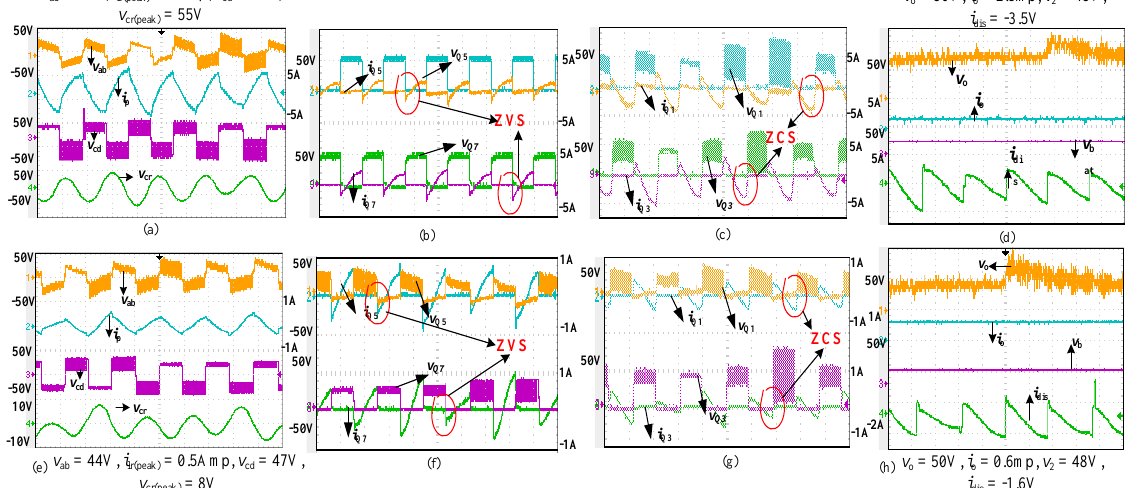
Figure 13. Reverse Mode Case 1: At full load ( a ) Waveforms of v ab , i p , v cd and v cr ( b ) waveforms showing ZVS for switches Q 5 & Q 7 ( c ) waveforms showing ZCS for switches Q 1 & Q 3 ( d ) Waveforms of v o , v b , i o and i s ; Case 2: ( e ) Waveforms of v ab , v cd , i p and v cr ( f ) waveforms showing ZVS for switches Q 5 & Q 7 ( g ) waveforms showing ZCS for switches Q 1 & Q 3 ( h ) Waveforms of v o , v b , i o and i s .